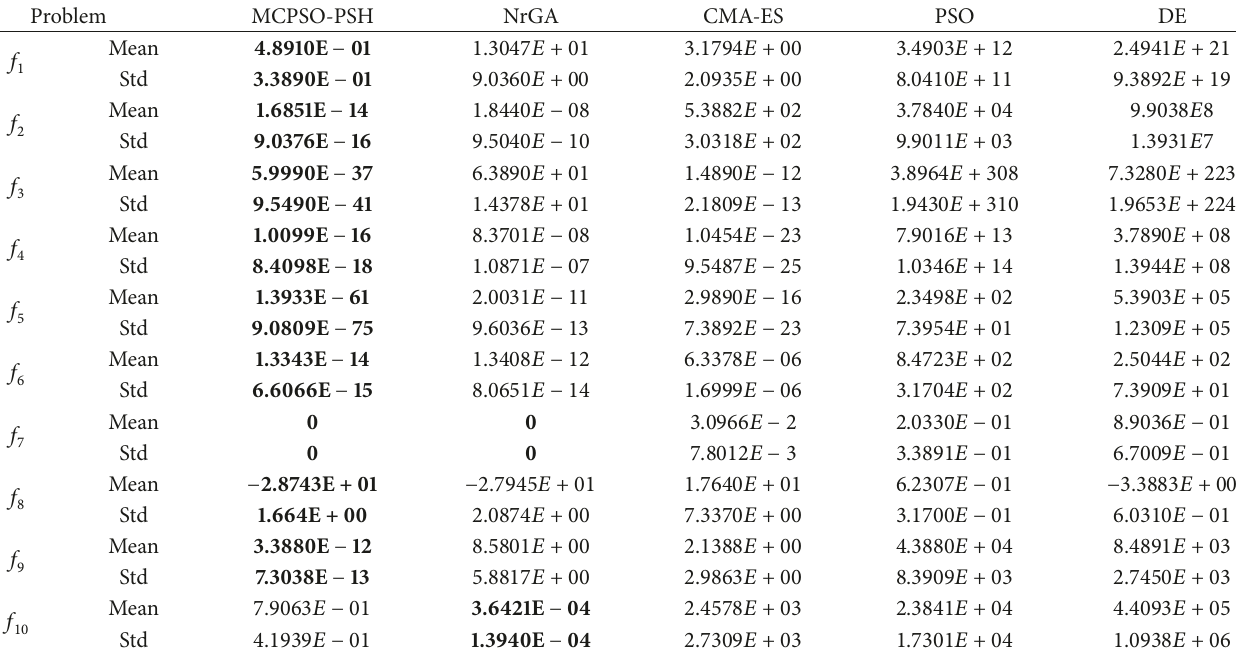
Table 2: Performance of all algorithms on 30D test functions 𝑓 1 – 𝑓 10